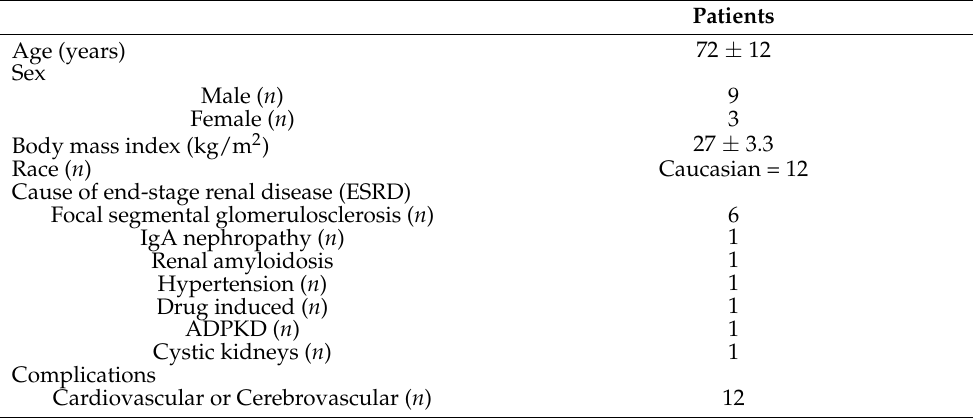
Table 1. Characteristics of patients ( n =